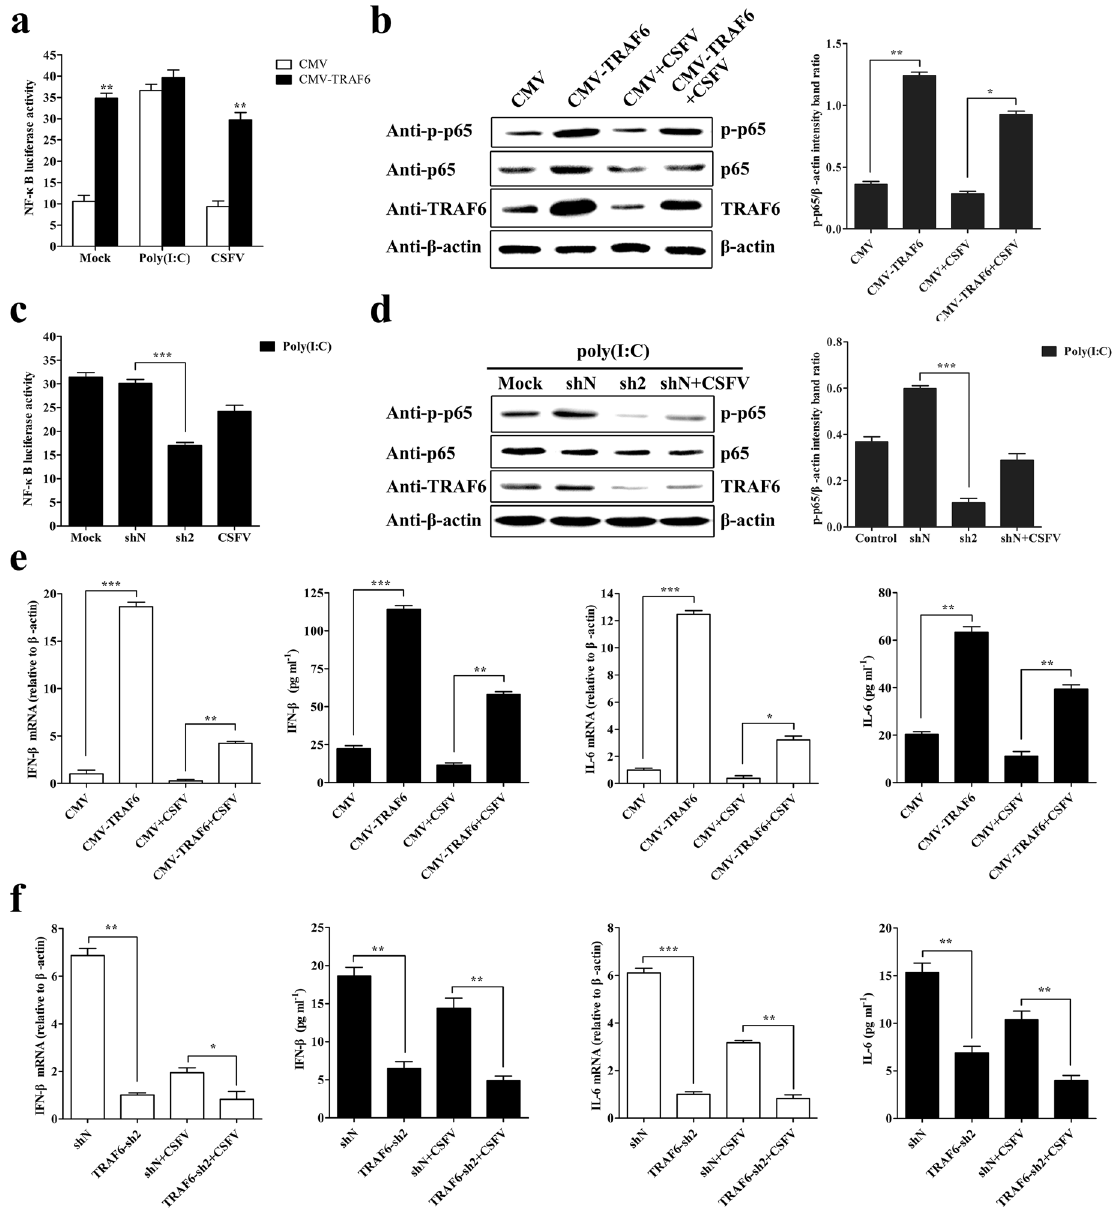
Figure 4. TRAF6 promotes NF- κ B activation and increases IFN- β and IL-6 expression in PAMs. ( a ) TRAF6 overexpression promotes NF- κ B activity. Stable cell lines were co-transfected with pNF- κ B-luc and pRL-TK plasmids. At 12 hpt, the cells were mock-infected, CSFV-infected, or poly (I:C)-stimulated for an additional 12 h. The dual-luciferase reporter assay determined NF- κ B luciferase activity. ( b ) Western blot for p65, p-p65, and TRAF6 expression in mock- and CSFV-infected CMV-TRAF6 cells. Cells stably expressing CMV or CMV-TRAF6 were mock- or CSFV-infected for 24 h, and the cell lysate was subjected to Western blot. ( c ) TRAF6 knockdown inhibits NF- κ B activity initiated by poly (I:C). Stable shN and TRAF6-sh2 cells were treated with poly (I:C), with shN cells infected with CSFV for 24 h, and PAMs treated with poly (I:C) as a mock condition. Cell lysates were used to determine NF- κ B luciferase activity. ( d ) Western blot for p65, p-p65, and TRAF6 expression in TRAF6-sh2 cells. Stable shN and TRAF6-sh2 cells were treated with poly (I:C), with shN cells infected with CSFV for 24 h, PAMs treated with poly (I:C) as a mock condition. Cell lysate was subjected to Western blot. The relative levels of p-p65 protein were estimated by histograms representing density readings of the gel bands, and the ratios were calculated relative to the β -actin control. ( e ) TRAF6 overexpression increases IFN- β and IL-6 expression in PAMs. Cells stably expressing CMV or CMV-TRAF6 were mock- or CSFV-infected for 24 h, followed by extraction of total RNA to determine relative IFN- β and IL-6 mRNA expression. The cell culture supernatant was used to determine IFN- β and IL-6 protein levels. ( f ) TRAF6 knockdown decreases IFN- β and IL-6 expression in PAMs. The stable shN and TRAF6-sh2 cells were mock- or CSFV-infected for 24 h. Relative IFN- β and IL-6 mRNA expression and protein levels were determined as described. The data represent the mean ± SD of three independent experiments. * P < 0.05, ** P < 0.01 and *** P < 0.001 compared with the controls calculated using Student’s t-test